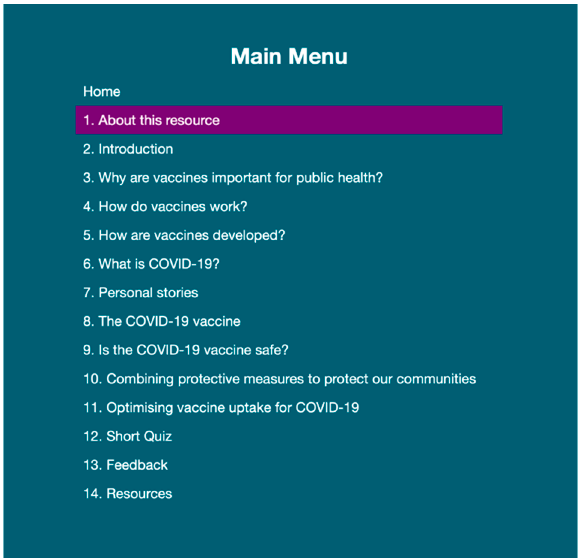
Figure 3. Final RLO contents list resulting from asynchronous storyboarding.